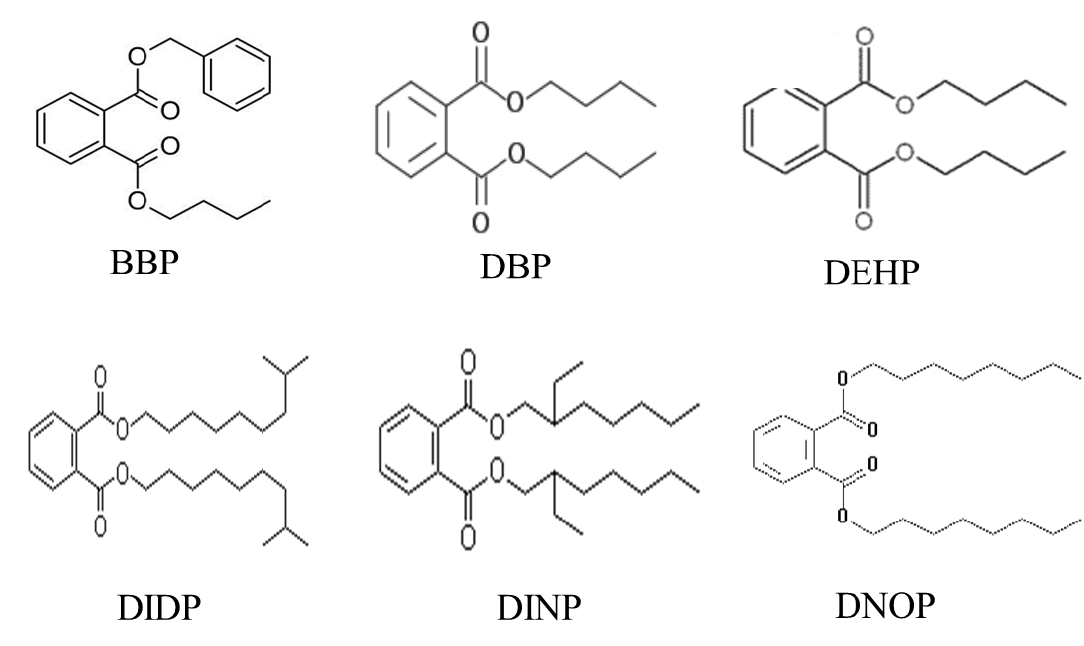
Figure 1. Chemical structure of